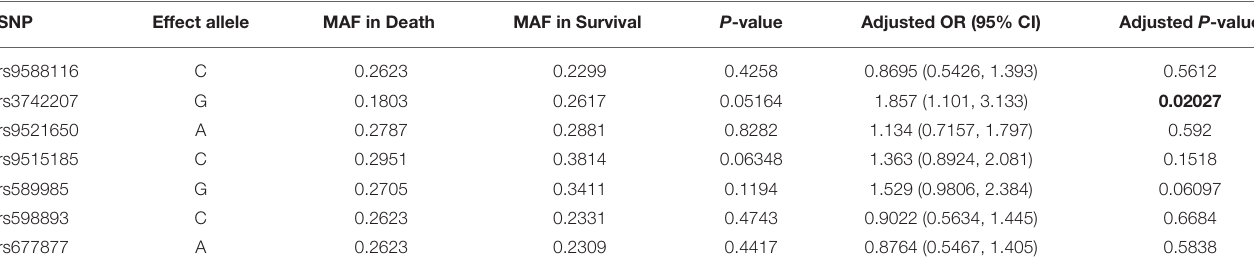
TABLE 5 | Association between alleles of COL4A1 and the death at 1-year follow-up in intracerebral hemorrhage